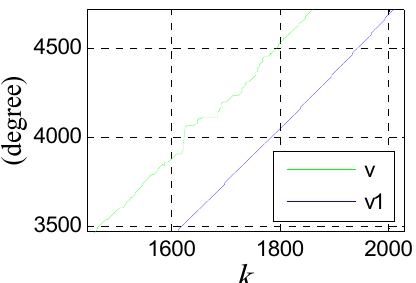
Figure 20. Filtering effect of the phase signal.